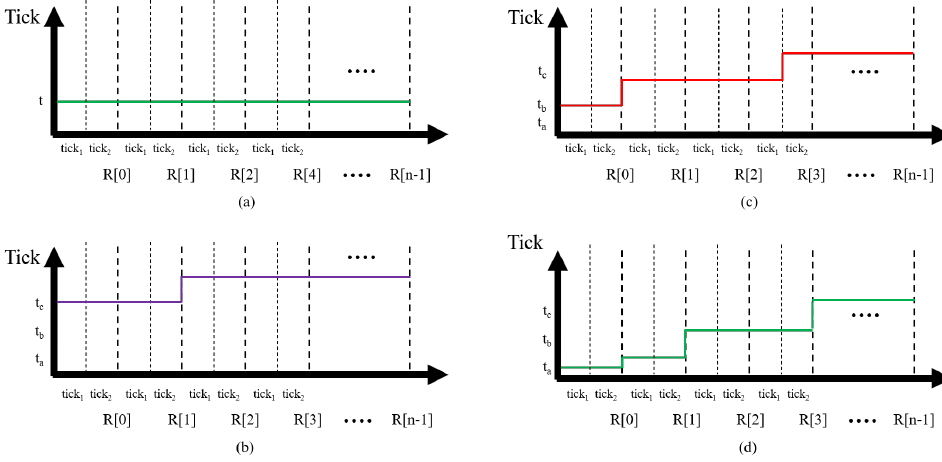
Figure 4. Tick changes during generation of an n -byte random string: ( a ) no tick changed, ( b ) one-tick changed, ( c ) two-tick changed and ( d ) three-tick